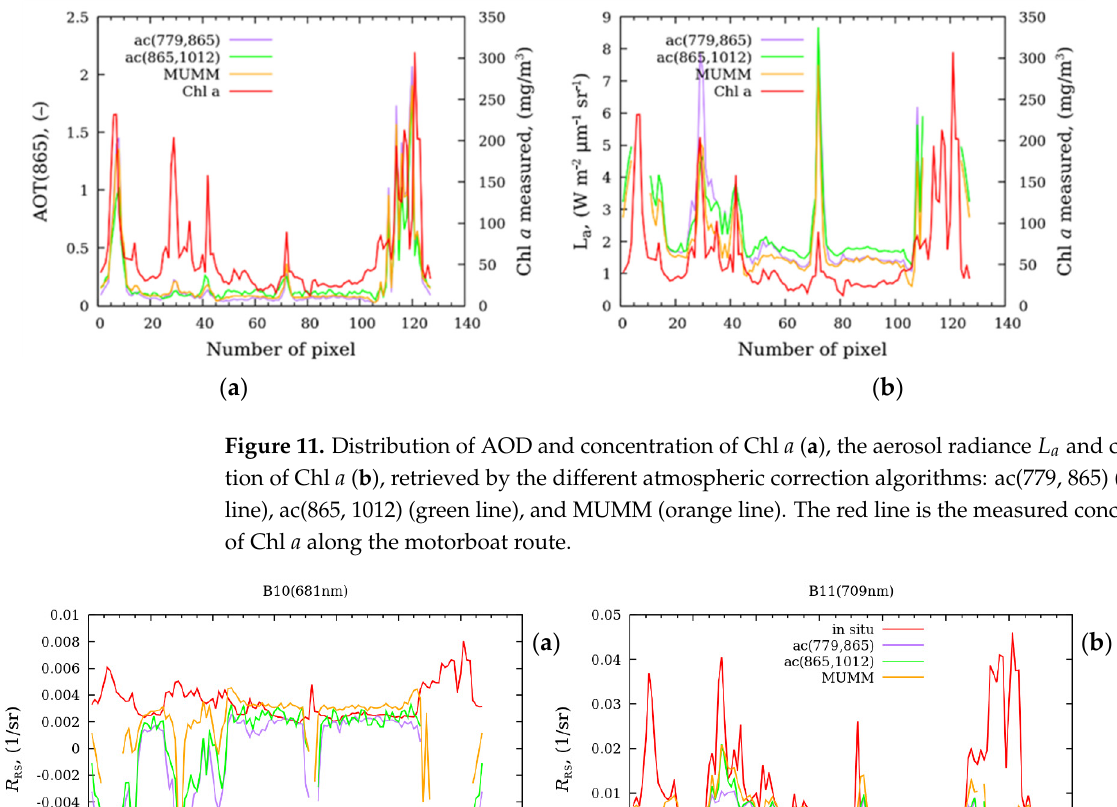
Figure 11. Distribution of AOD and concentration of Chl a ( a ), the aerosol radiance L a and concentration of Chl a ( b ), retrieved by the different atmospheric correction algorithms: ac(779, 865) (magenta line), ac(865, 1012) (green line), and MUMM (orange line). The red line is the measured concentration of Chl a along the motorboat route.